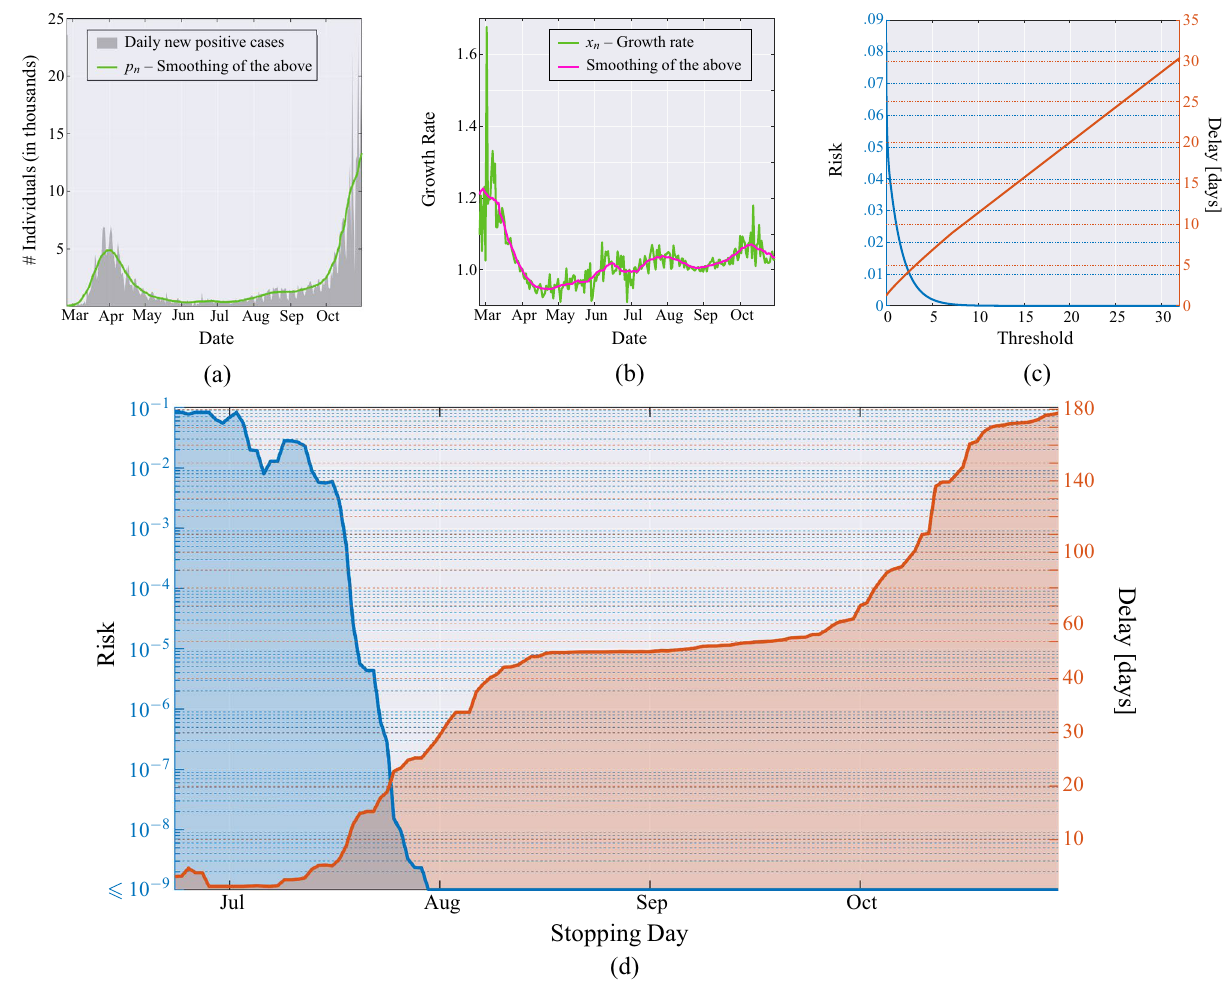
Figure 10. Germany. ( a ) Daily new positive individuals in Germany since February 25, 2020, and its moving average obtained with a window of 21 days (green line). ( b ) Growth rate of the epidemic computed from the averaged daily new positive cases (green line), and its time-varying mean obtained through a moving average that uses a window of 21 days (magenta line). ( c ) MAST performance, in terms of risk (left axis) versus threshold and mean delay (right axis) versus threshold, obtained from the German data of the COVID-19 pandemic. ( d ) Application of the MAST procedure on the COVID-19 pandemic data from Germany. On the left-side vertical axis, we select a desired risk, e.g., R = 10 − 4 . Then, the blue curve indicates the stopping day (about July 19, in the example) corresponding to the selected value of risk. Finally, the red curve referred to the right-side vertical axis shows the mean delay (cid:31) corresponding to the selected risk R (below 13 days). For clarity, note that the right-side scale for the delay is split into two linear ranges, for a better rendering of the small- (cid:31)